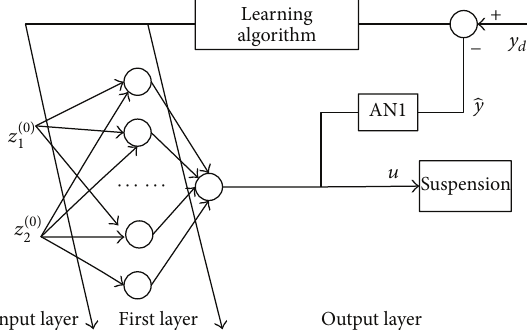
Figure 3: Adaptive neural network structure. Figure 4: Adaptive neural network